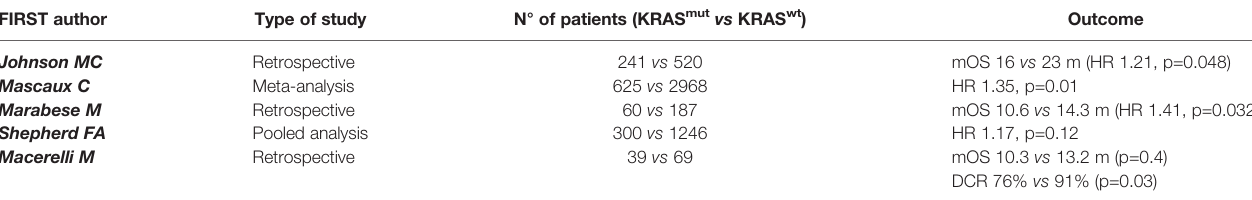
TABLE 1 | Trials evaluating KRAS as a prognostic